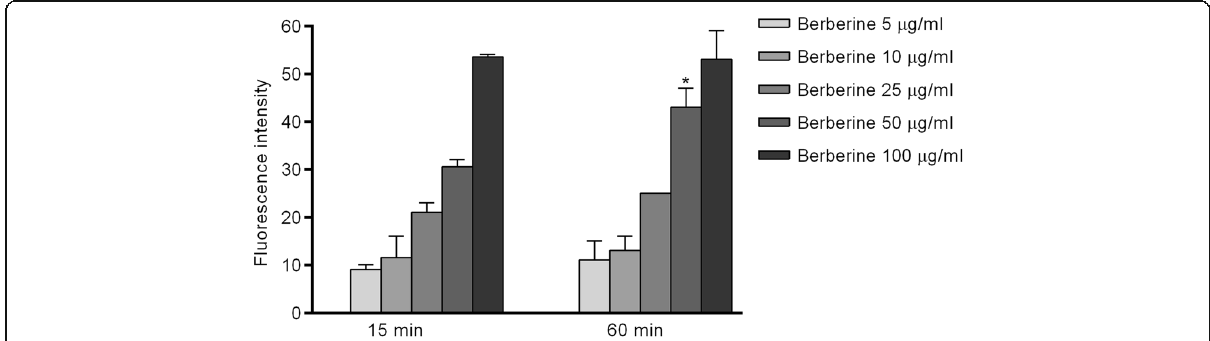
Fig. 1 Fluorescence emitted by berberine sulfate upon intracellular localization in C. albicans cells. The samples were treated with different berberine concentrations for 15 and 60 min. The data are shown as means ±